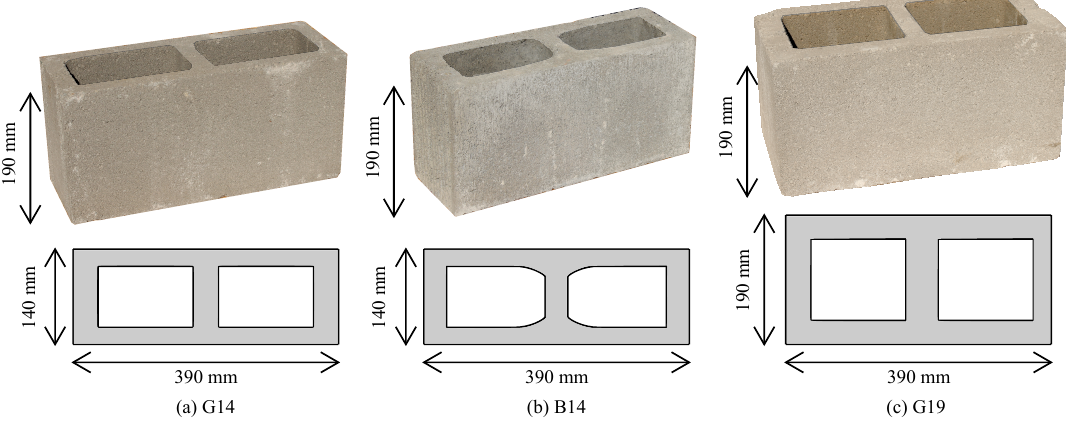
Figure 2. Employed hollow concrete block types: ( a ) G14, ( b ) B14, and ( c )